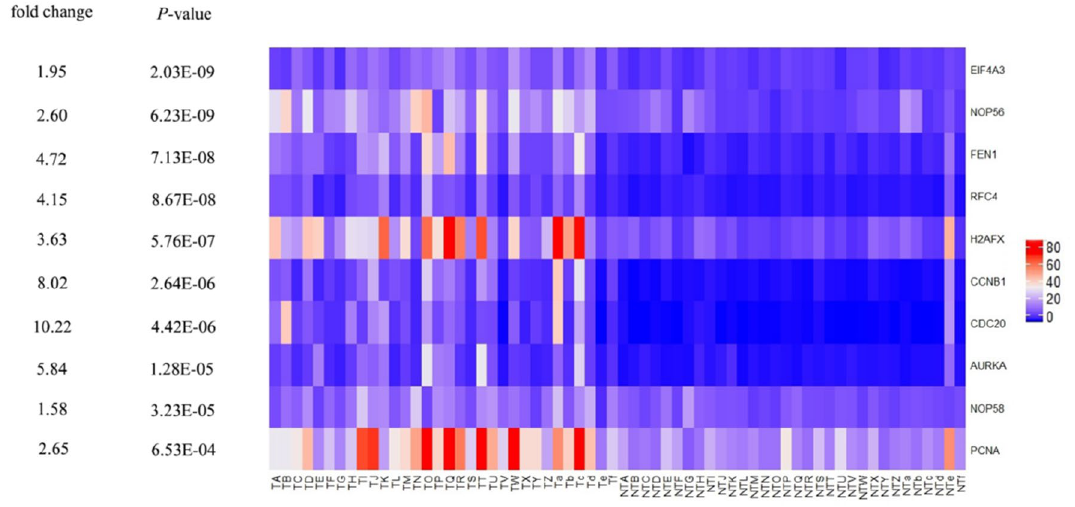
Figure 9. The heat map of RPKM of key genes identified by GCNA-Kpca algorithm in normal and HCC samples. TA-Tf represents HCC samples in GSE138485, NTA-NTf represents normal samples in GSE138485. This figure was drawn with R software 16